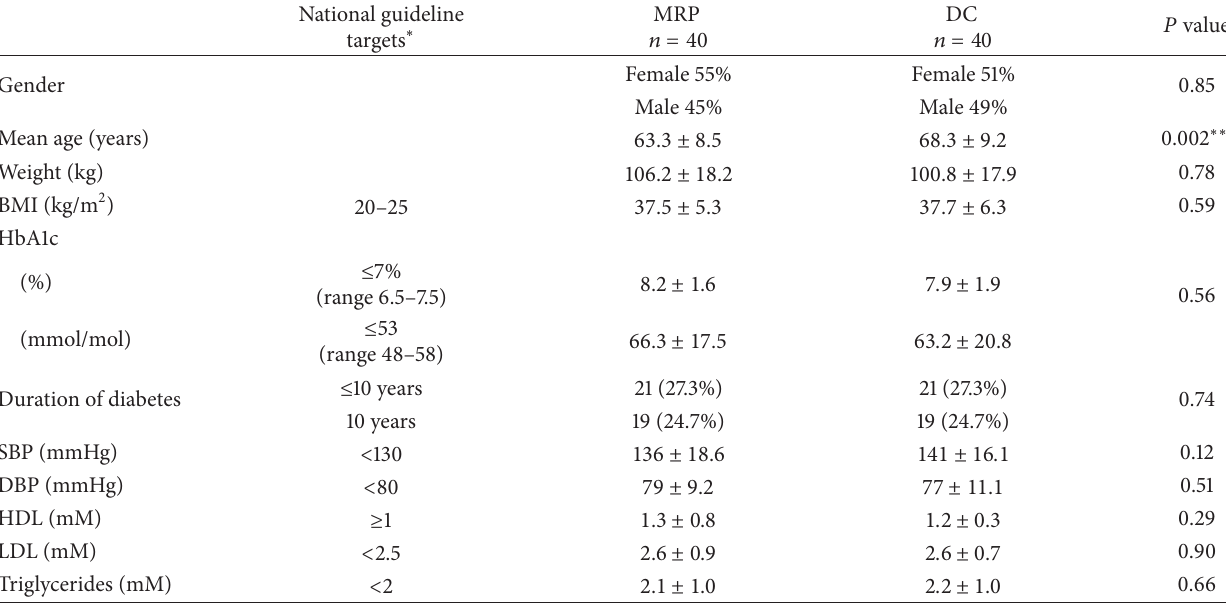
Table 1: Baseline characteristics of patients enrolled in the diabetes clinic (DC) and Metabolic Rehabilitation Program